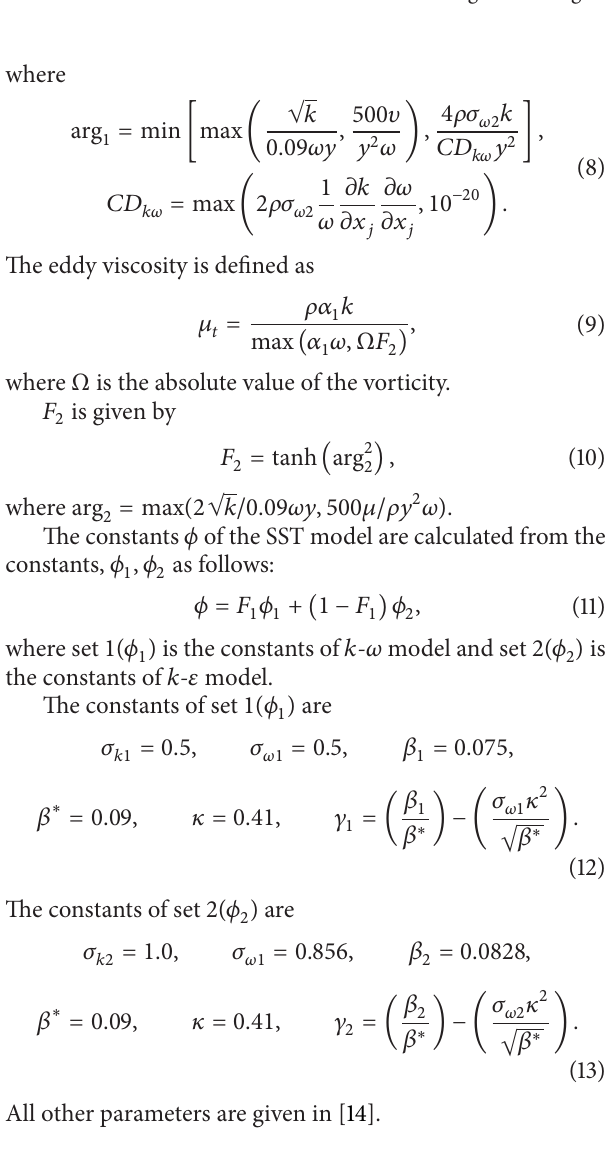
Figure 6: Distributed normal force coefficients along rocket